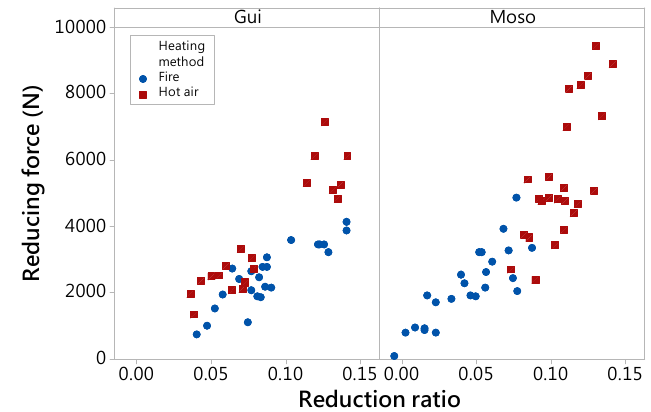
Figure 7. The reducing forces for various reduction ratios for the samples.